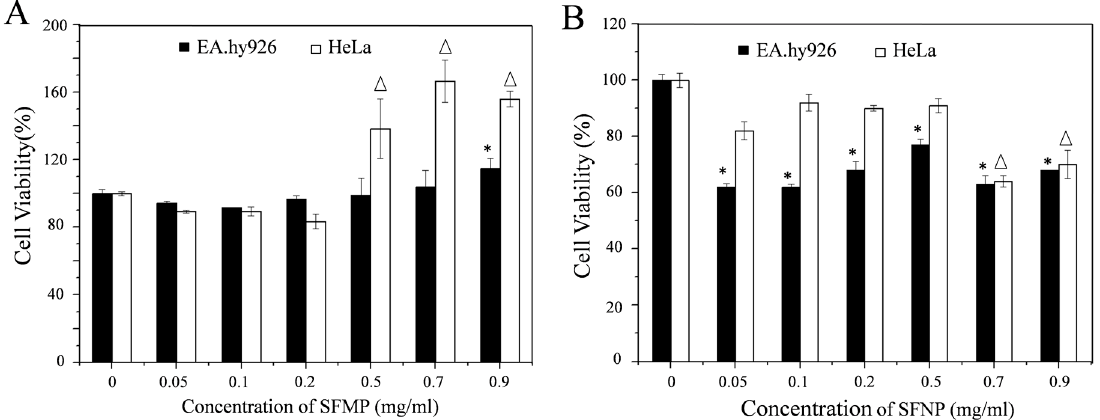
Figure 7. EA.hy926 and HeLa cell viability after 24 h of incubation with different concentrations of SFMPs and SFNPs. blank cell as a control. ( A ) SFMPs; ( B ) SFNPs. * and ∆ data points for the experimental group that were statistically significant compared with the control group ( p < 0.05).